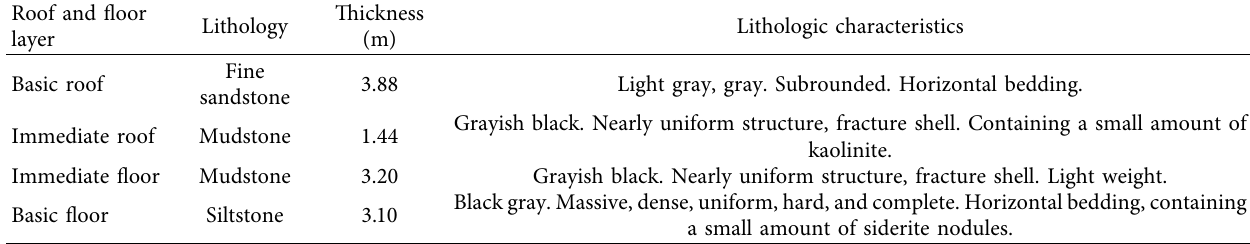
Table 2: Roof and floor